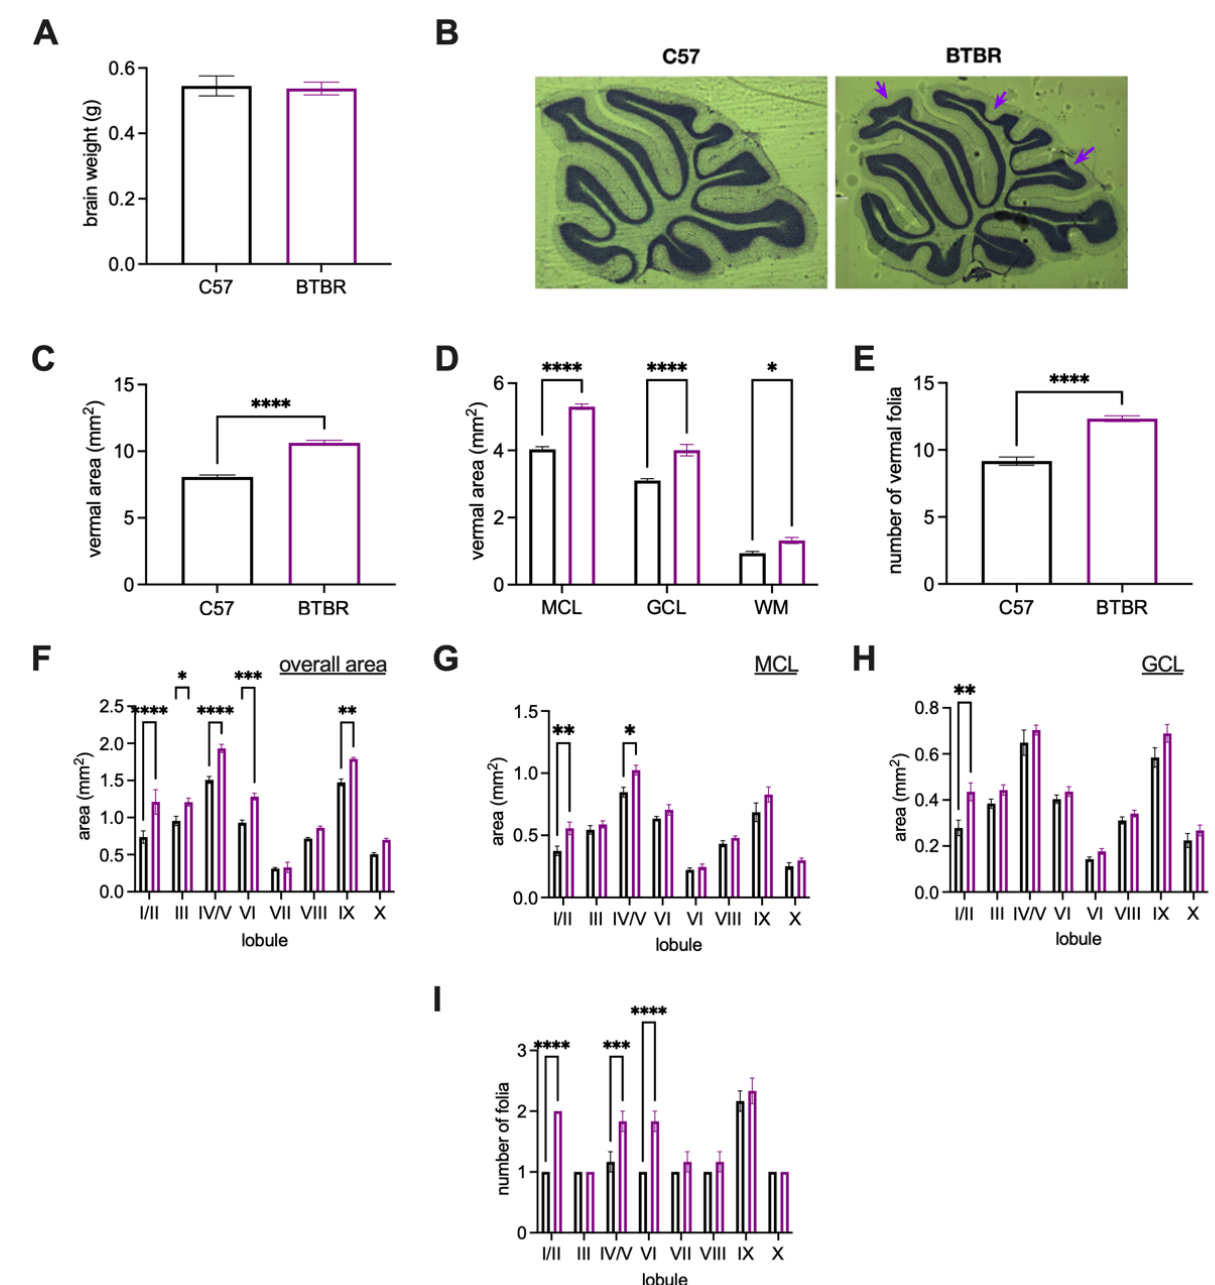
Figure 3. Female BTBR mice show vermal enlargement and foliation that varies by lobule. ( A ) Brain weight is comparable between strains. ( B ) Representative image of gross anatomical differences between C57 (left) and BTBR (right) sagittal vermis sections. Arrows identify additional lobules in the BTBR section. ( C ) Area of the midline vermal section is significantly larger in BTBR mice. ( D ) Molecular cell layer (MCL), granule cell layer (GCL), and white matter areas are all significantly enlarged in the BTBR vermis. ( E ) The number of folia in the vermis is significantly different in BTBR mice. ( F ) Enlargement of vermis area in BTBR mice depends on lobule. ( G ) Enlargement of area of the molecular cell layer in BTBR mice depends on lobule. ( H ) Enlargement of area of the granule cell layer in BTBR mice depends on lobule. ( I ) Abnormal foliation in BTBR mice depends on lobule. Black, C57B6/J mice; purple, BTBR mice. Error bars denote standard error of the mean. Asterisks denote significant results from two-sample t -tests ( A – E ) or planned comparisons following a significant two-way ANOVA ( F – I ). *, p < 0.05; **, p < 0.01; ***, p < 0.001; ****, p < 0.0001.